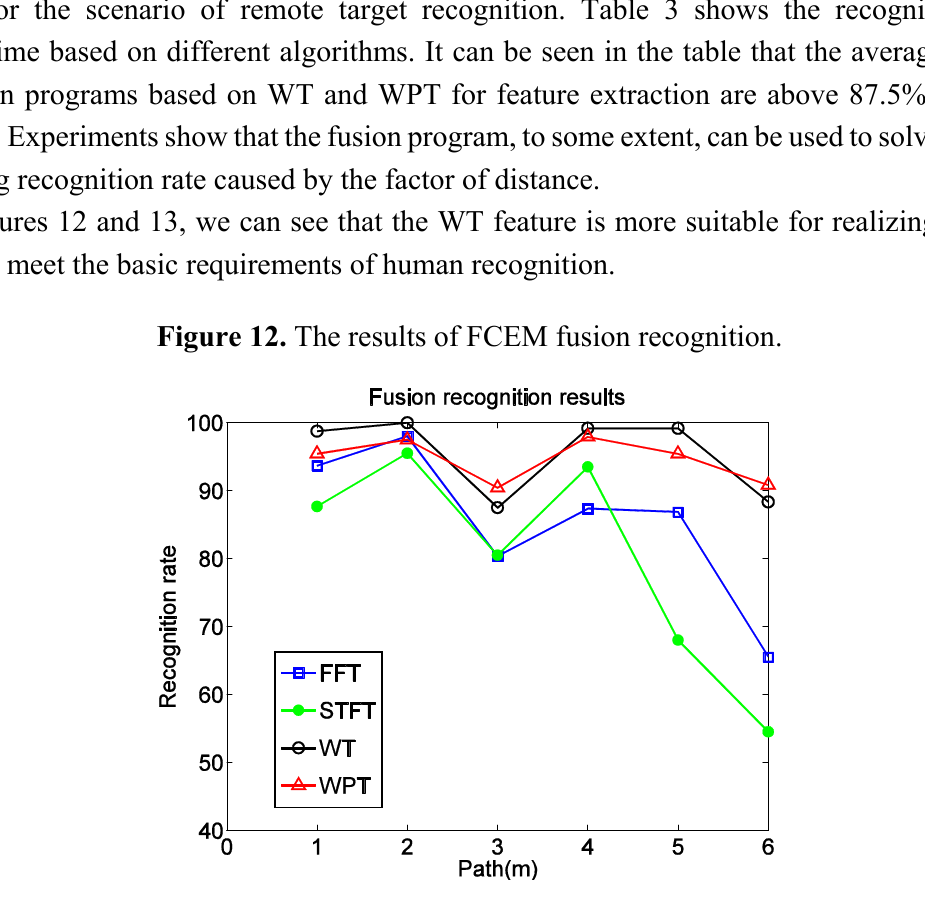
Figure 13. The upgrade percentage of recognition rate after